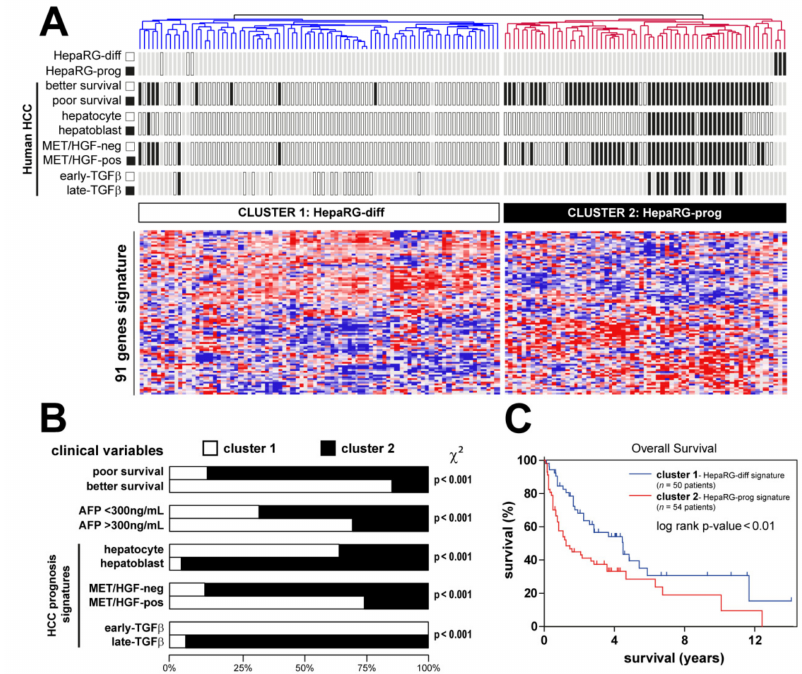
Figure 4. Clinical relevance of HepaRG signature in human HCC. ( A ) Dendrogram overview of in vitro experiments using differentiated and progenitor HepaRG cells (Figure 2) integrated with 139 cases of human HCC (NCI training set, Figure 1). Clustering analysis was based on the expression of genes differentially expressed between differentiated and progenitor HepaRG (Table S1). Two main clusters were identified: cluster 1 and cluster 2, associated with differentiated and progenitor HepaRG, respectively. Distribution of HCC samples between previously described subgroups with respect to survival (better vs. poor prognosis) [7], cell origin (hepatocyte vs. hepatoblast) [10], activation of MET/HGF (negative vs. positive) [29] and TGF β signaling (early vs. late) [19] is indicated on the left side. ( B ) Statistical analysis of HCC distribution between clusters 1 and 2 based on previous gene expression signatures and clinical parameters. Cluster 2 (defined by a high expression of genes reflecting the HepaRG progenitor state) shows a significant enrichment in human HCC with the following features: poor survival, hepatoblast traits, activation of MET/HGF, late TGF β pathways and higher serum AFP levels. ( C ) Kaplan–Meier plot and log-rank statistics analysis revealed a significant decrease in overall survival for patients included in cluster